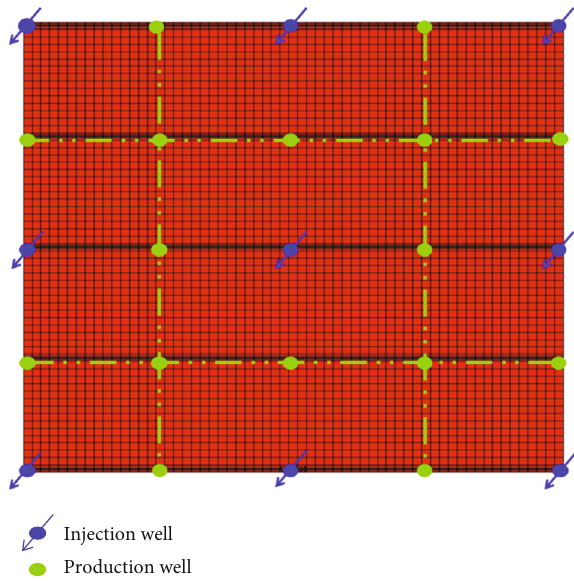
Figure 1: Schematic of the grid model and well